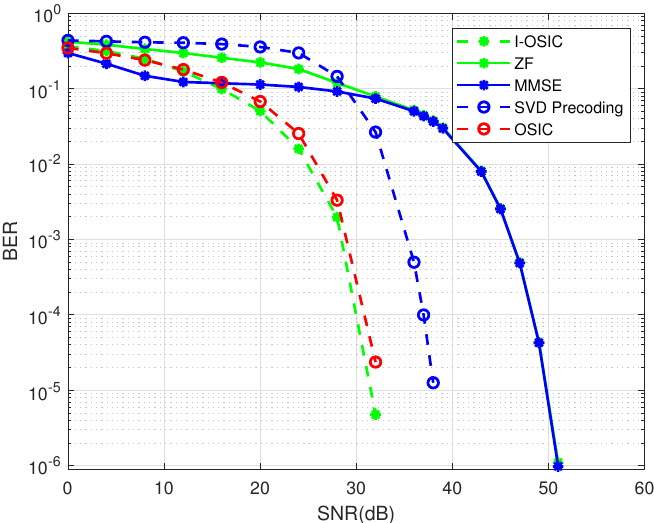
Figure 11. Receiver and transmitter aligned system BER performance.